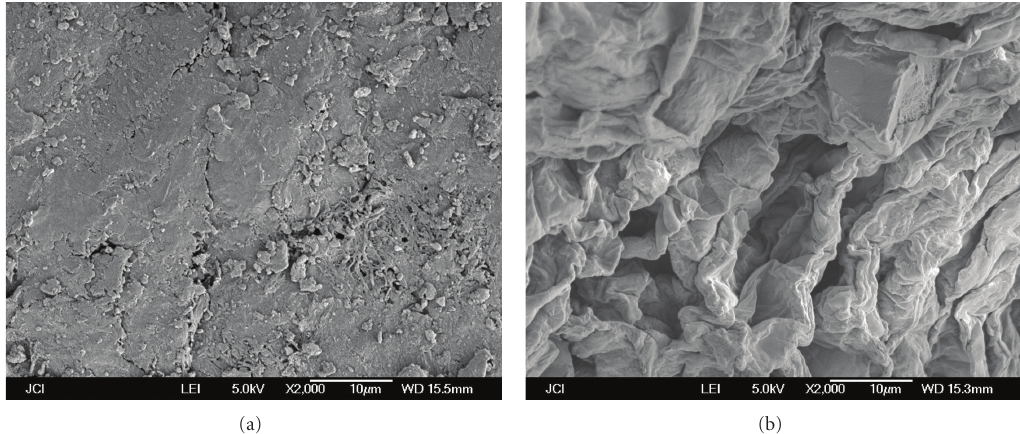
Figure 6: Scanning electron micrographs of lemon peels: pretreated lemon peels (a); after MAE for 10 min (b).